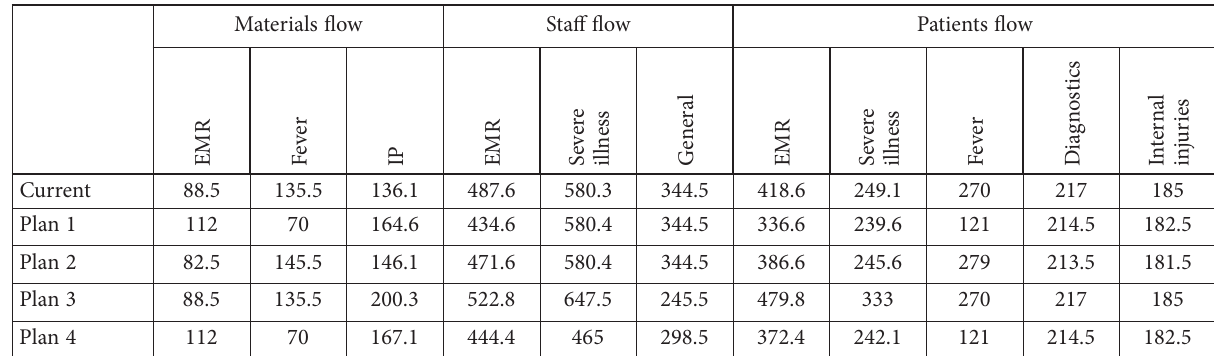
Table 6. Overall distance